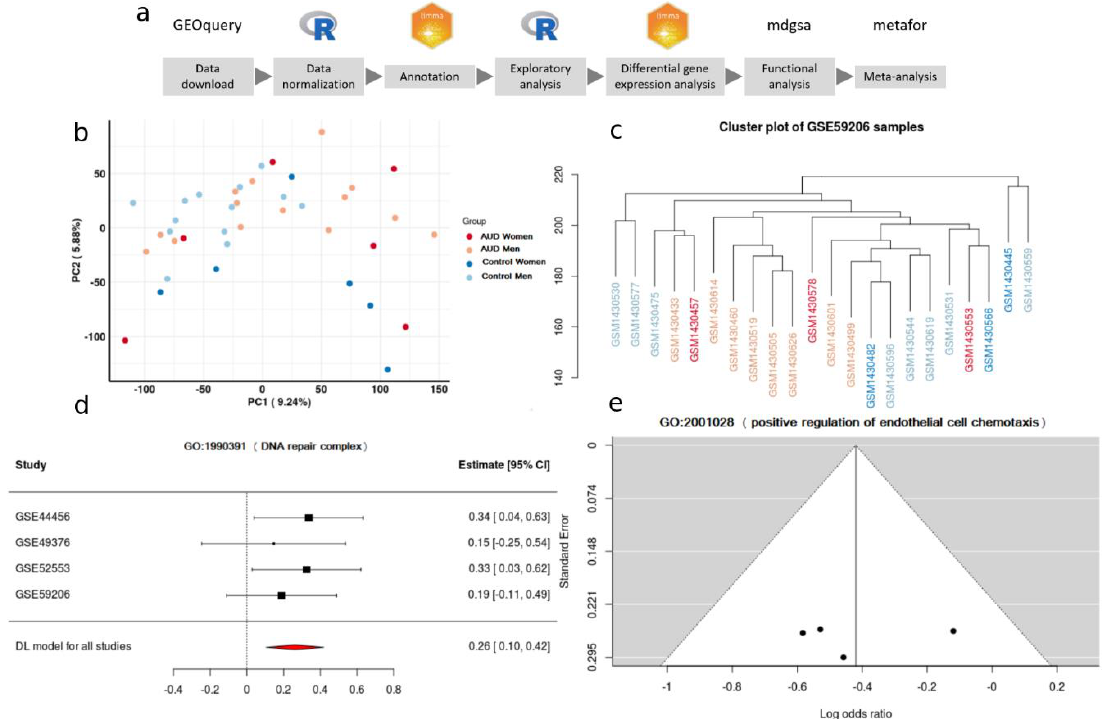
Figure 1. ( a ) Data-analysis workflow. ( b ) Principal Component Analysis plot in the GSE44456 study. ( c ) Clustering. ( d ) A forest plot of the GO:1900391, showing the LOR (log odds ratio) of each study and the global result. ( e ) Funnel plot of the GO:2001028; dots in the white area indicates the absence of bias and heterogeneity.